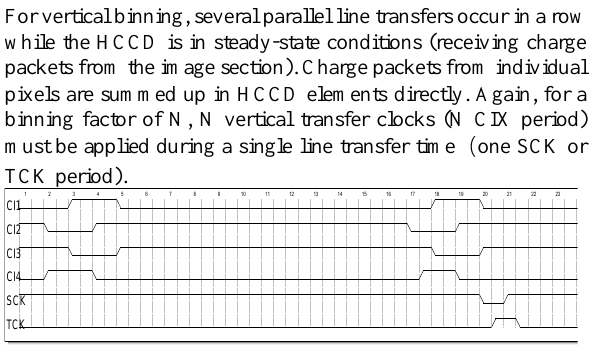
Figure 10. Vertical Binning clock sequence diagram